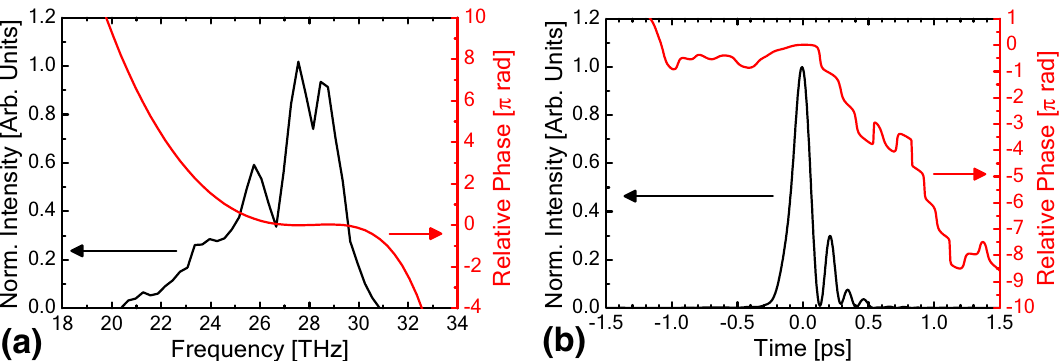
Figure 2. ( a ) Measured FEL spectrum and spectral phase. ( b ) Retrieved pulse shape and temporal phase of the FEL pulse generated at KU-FEL under the condition having an energy extraction efficiency of approximately